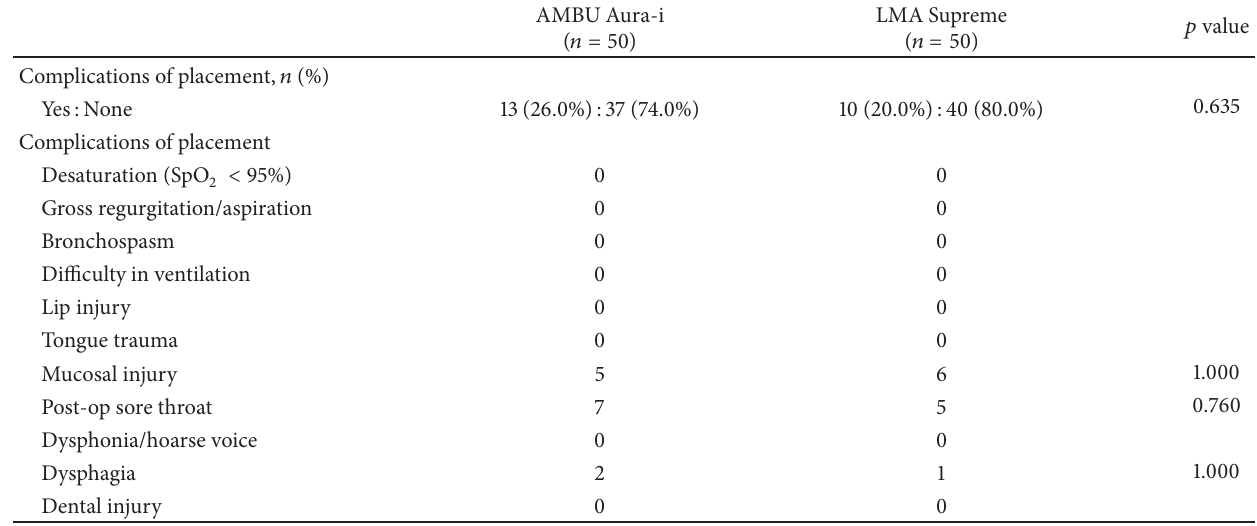
Table 3: Complications of placement. Values are expressed in mean (SD) or numbers of patients ( 𝑛 ) and percentages (%). AMBU Aura-i